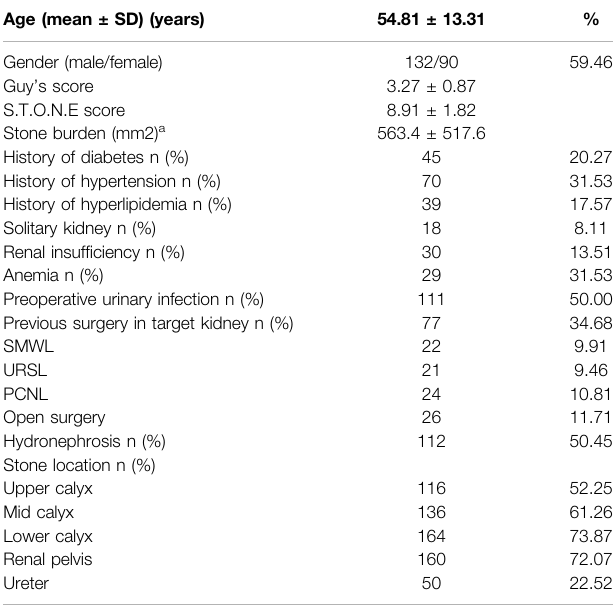
TABLE 1 | Preoperative factors include individual variables and renal and stone factors. Age (mean ± SD) (years)